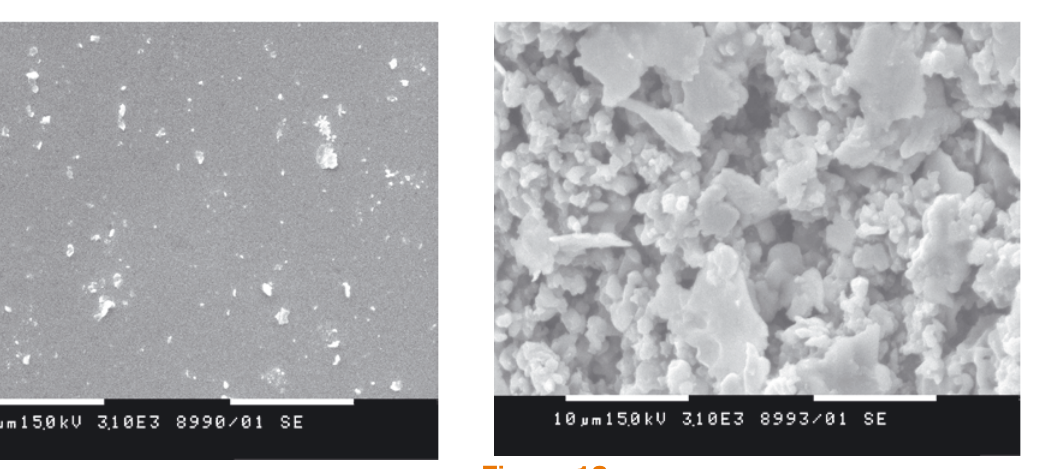
Figure 11. SEM of the G/S (75:25wt.%) hybrid before immersion in 1.5